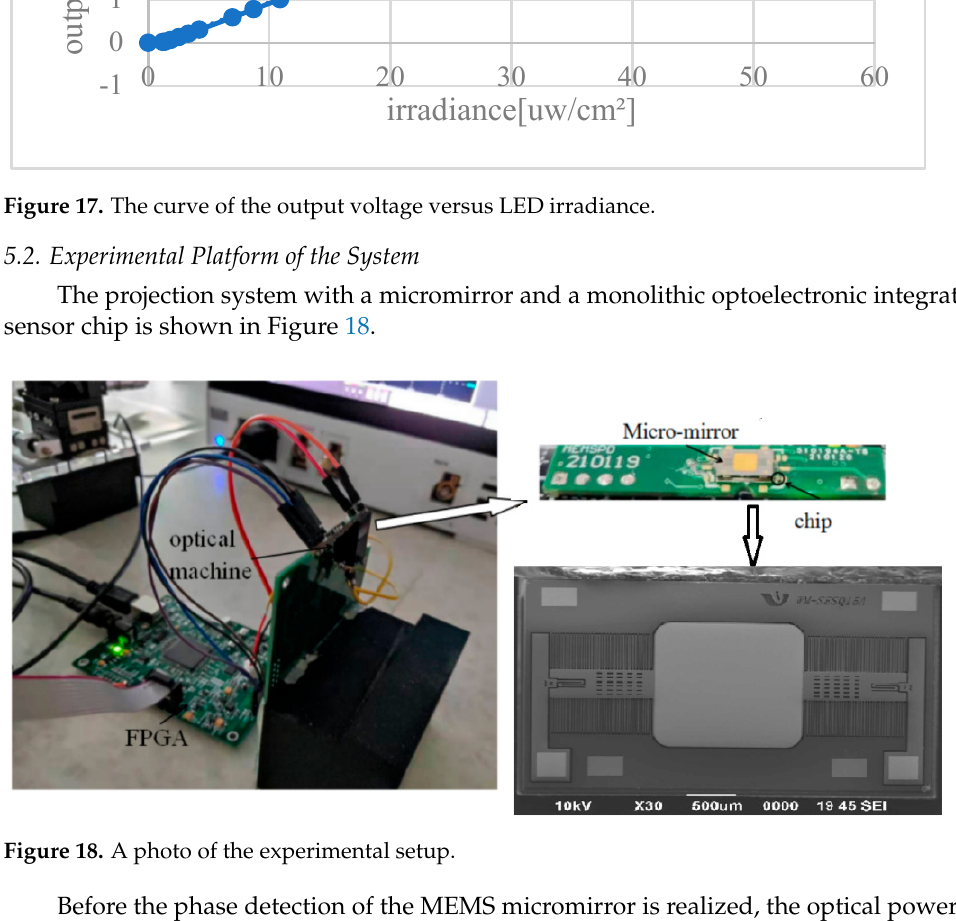
Figure 18. A photo of the experimental setup.